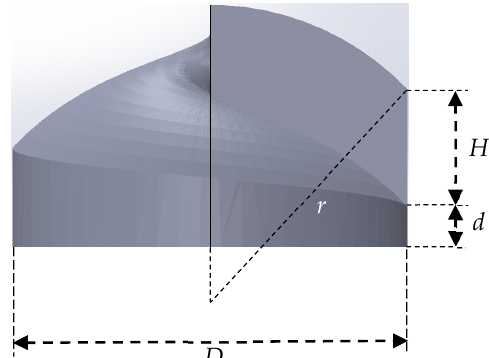
Table 1. Parameter-Value correspondence table.